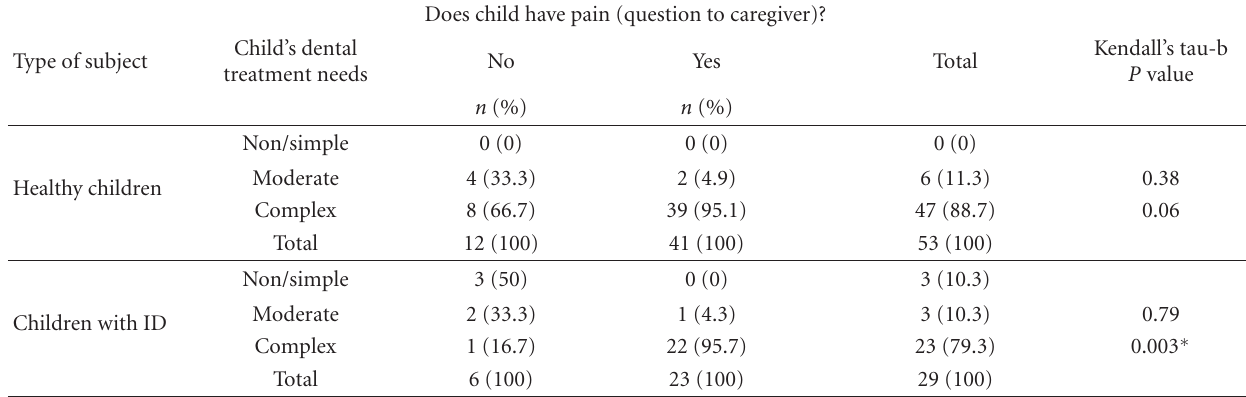
Table 5: Association between dental treatment needs and caregivers’ ability to recognize presence of pain. Does child have pain (question to